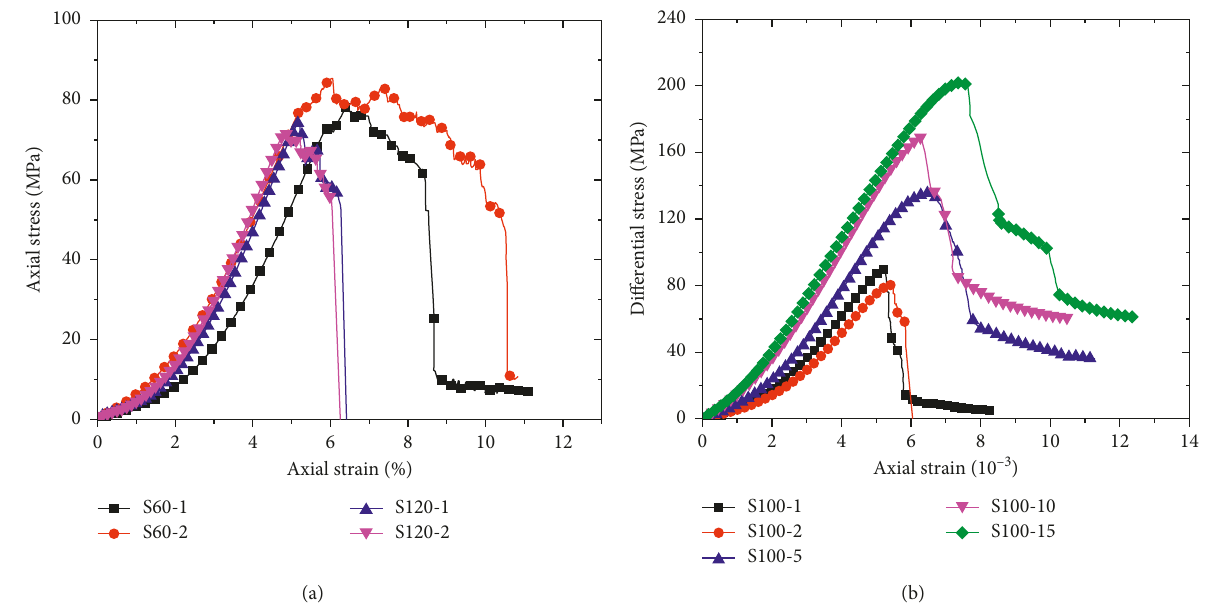
Figure 1: Stress-strain curves of the sandstone specimens with (a) different H / D s and (b) confining pressures. Table 1: Size, H / D , Young’s modulus ( E ), peak strength ( σ